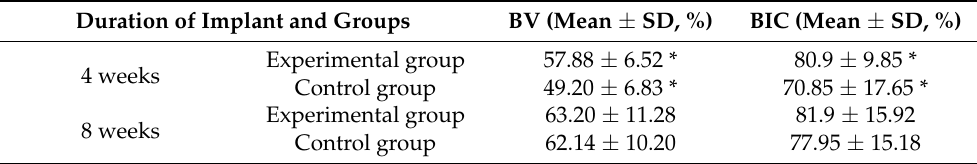
Table 1. Mean ± standard deviations of bone volume (BV) and bone-to-implant contact (BIC) ratio. Duration of Implant and Groups BV (Mean ± SD, %) 4